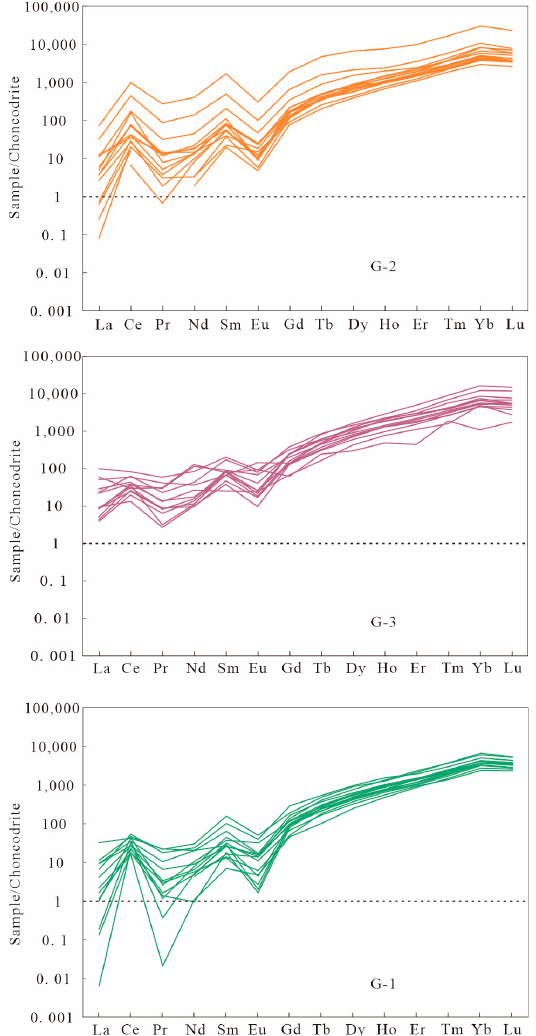
Figure 12. Chondrite-normalized REE patterns of zircon grains from igneous rocks in Chuankou ore field (Standardized value from [48]).